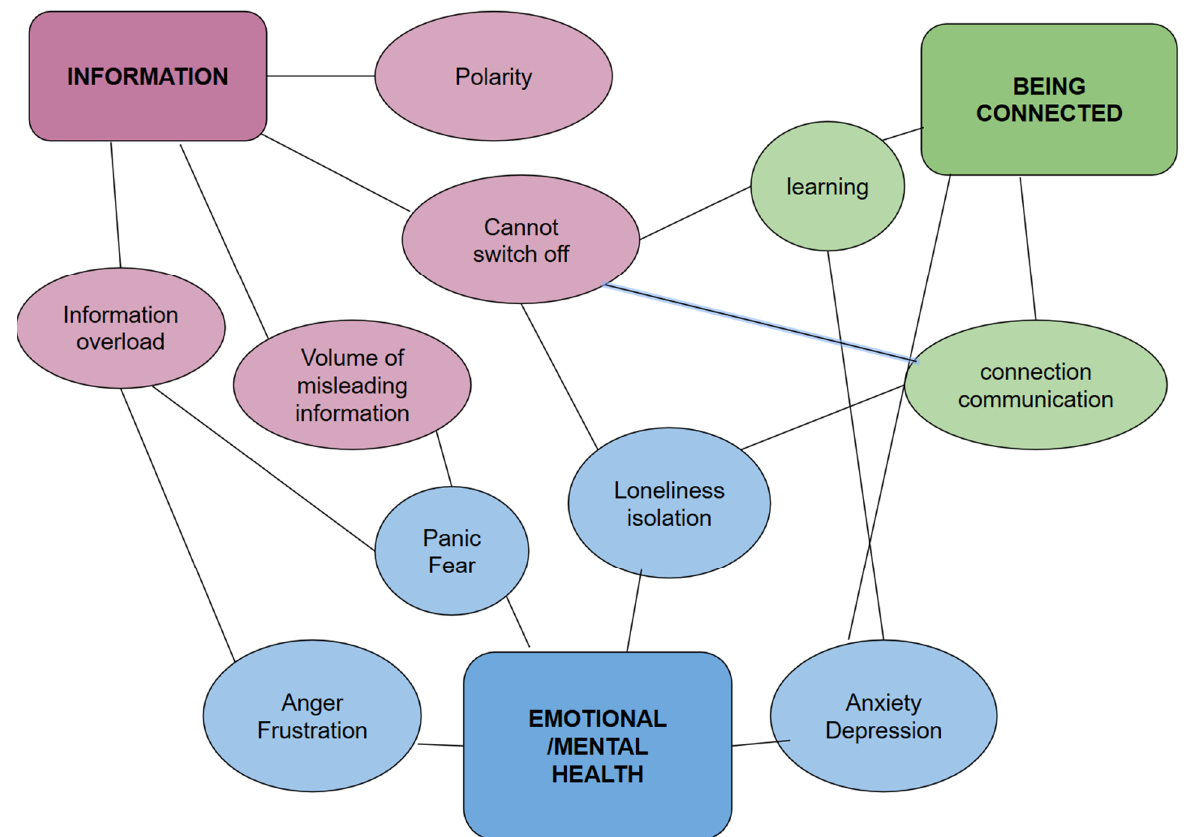
Figure 1. Matrix of interconnectedness of themes and subthemes.